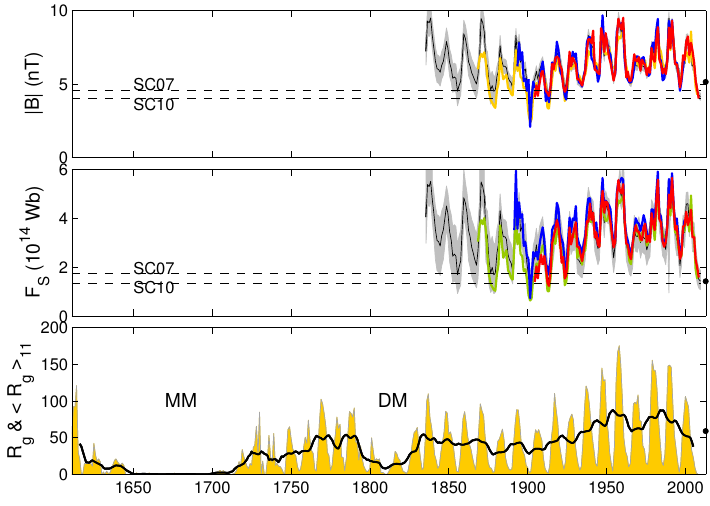
Figure 30: Long-term variations in (top) reconstructed IMF, 𝐵 ; (middle) open solar flux, 𝐹 𝑆 ; and (bottom) group sunspot number, 𝑅 𝑔 . The upper two panels are as in Figures 26 and 28. In the bottom panel the orange-shaded area gives annual means of the group sunspot number and the black line their 11-year running means. The black dot to the right of each panel is the maximum 12-month mean seen thus far in cycle 24 at the time of writing (31 March